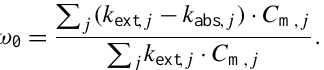
Table 5. Concentrations of major crustal (Si, Al, Fe and Ca, in ngm − 3 ) and metallic tracers (V, Pb and Zn, in ng m − 3 ) , ionic species (SO 2 −